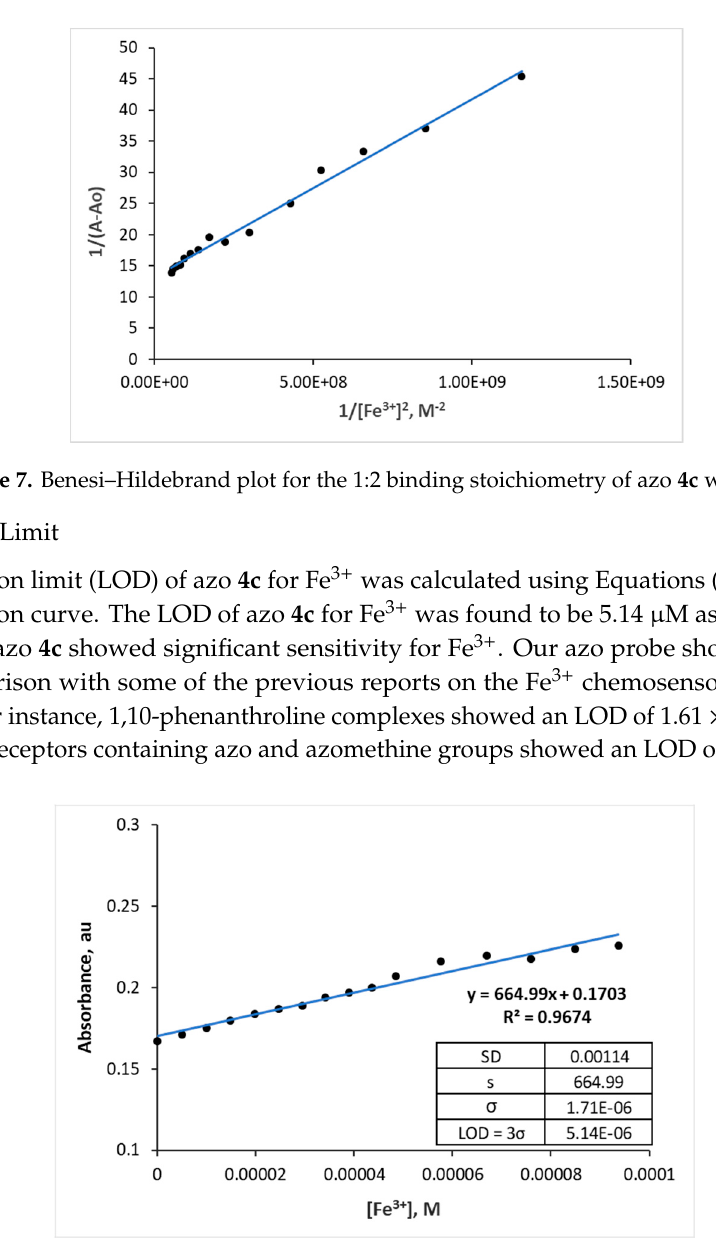
Figure 8. Calibration curve for the absorbance of azo 4c as a function of [Fe 3+ ].